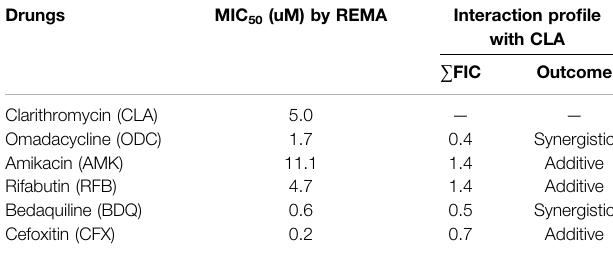
TABLE 1 | MICs of selected anti- M . abscessus drugs against M. abscessus subsp. abscessus CIP 104536 T and corresponding interaction pro fi les with clarithromycin (CLA) evaluatedby REMA